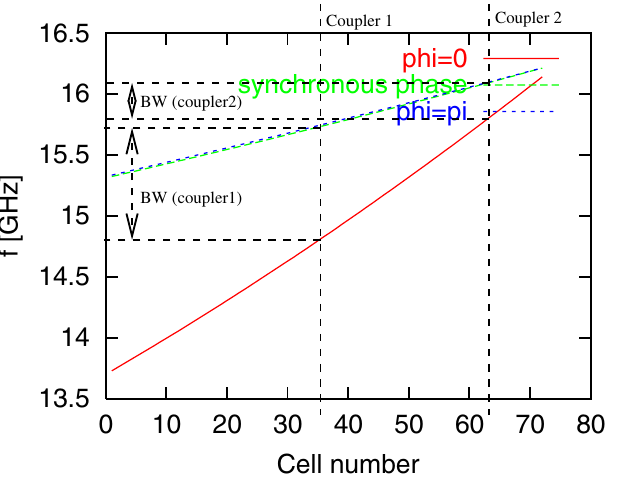
FIG. 7. (Color) Transverse wake impedance for the structure as calculated via the dual resonator model